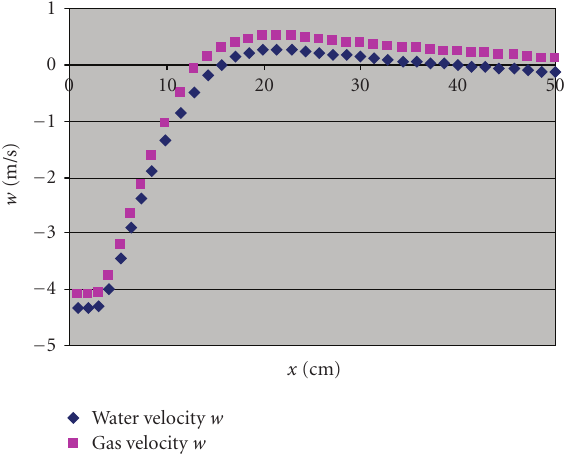
Figure 7: Vertical velocities as a function of the horizontal distance to the jet axis, 30 cm below the water level ( C D = 0 .